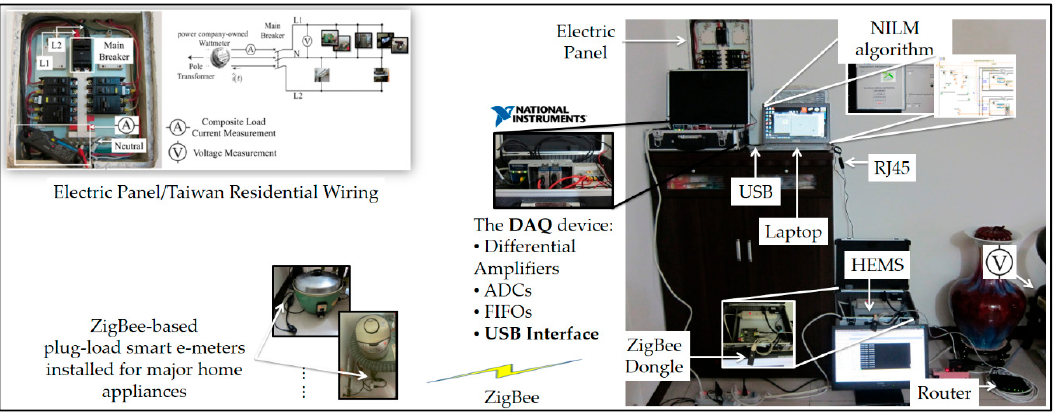
Figure 5. Experimental set-up of the IoT-oriented smart HEMS utilizing the proposed novel hybrid UAC-NFC model in a realistic residential environment. Appl. Sci. 2018 , 8 , x FOR PEER REVIEW